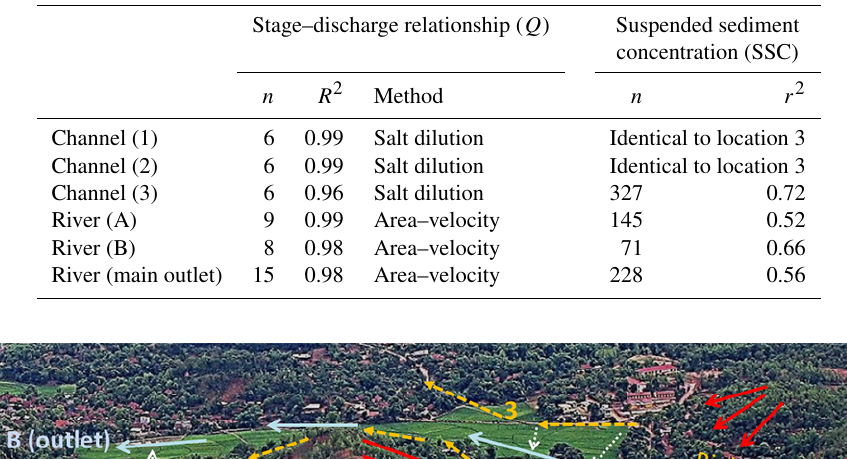
Table 1. Number of observations ( n ), coefficient of determination ( R 2 ) and method used for stage–discharge relationship ( Q ); number of observations and Pearson’s correlation coefficient ( r 2 ) after 5-fold cross validation for suspended sediment concentration predictions (SSC). Details on the linear mixed model development can be found in Slaets et al. (2014).